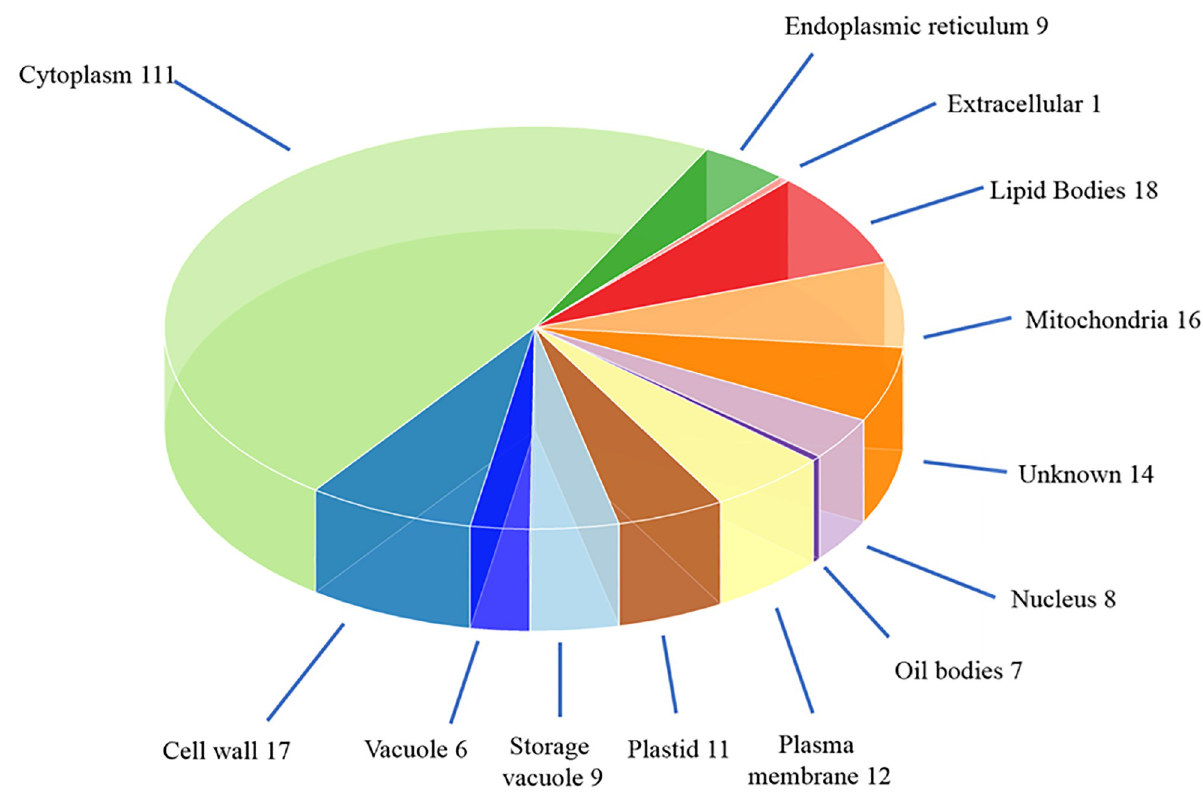
Fig 3. Distribution of proteins identified from Brassica rapa R-o-18 seed extract according to GO cellular component annotations. The proteins identified from Brassica rapa R-o-18 seed extract using LC-MS/MS were categorized based on Gene Ontology (GO) annotation as described in Material and Methods. Ten ‘cellular component’ categories were assigned to 219 proteins with 14 unknown proteins remaining uncategorized. Table in S1 File) [57–59]. Oleosins and other oil body associated proteins accounted for 19.8